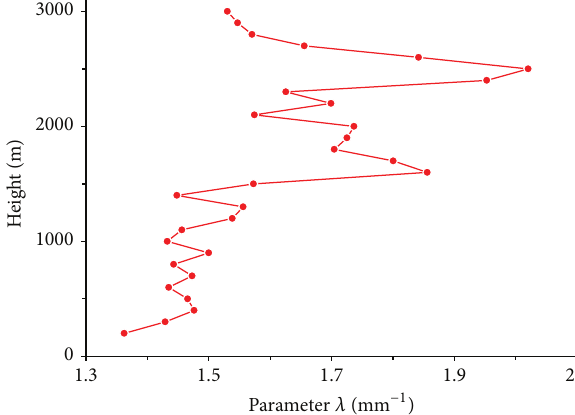
Figure 6: Parameter 𝜆 for the raindrop size spectra at the different heights considered during the hour of precipitation in the 30 height levels